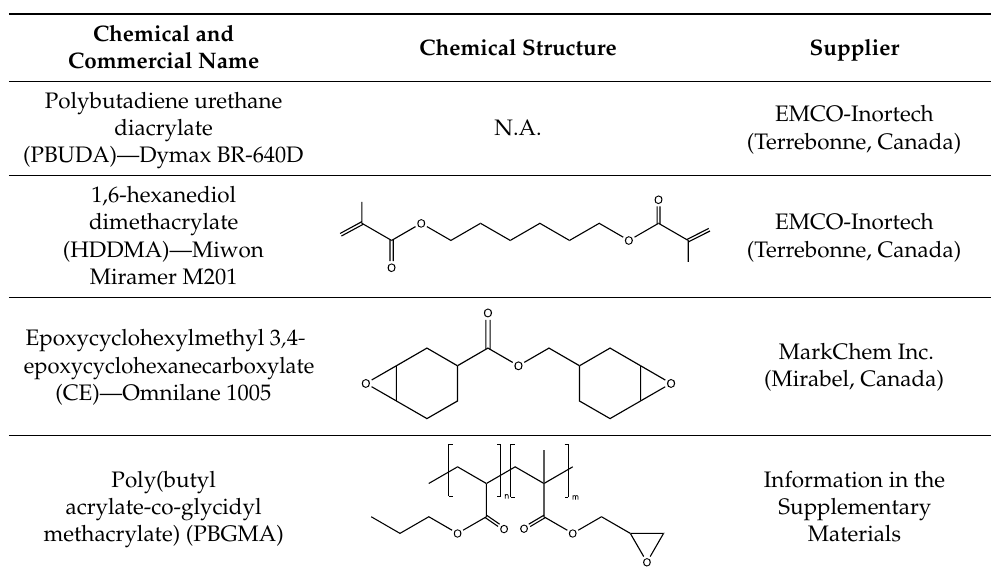
Table 1. Chemical and commercial names, chemical structures, and suppliers of the UV-curable chemicals used in the study.